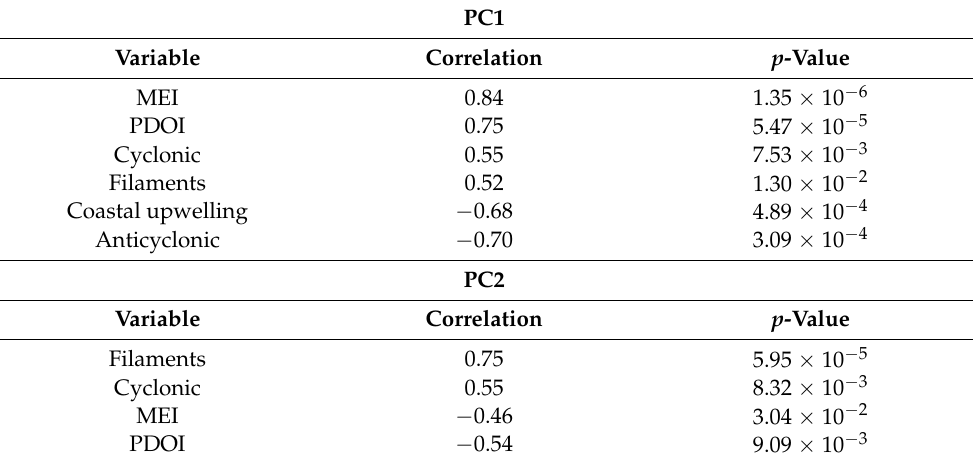
Table 1. Significantly associated variables within principal component 1 and 2 in the Northern Gulf of